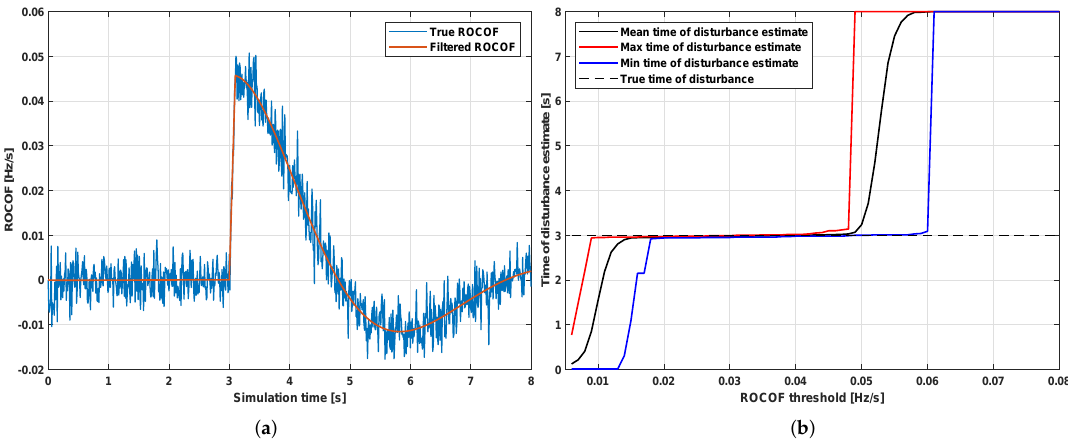
Figure 6. Comparison between true and filtered ROCOF for case B ( a ); time of disturbance estimation by means of ROCOF trespassing criterion ( b